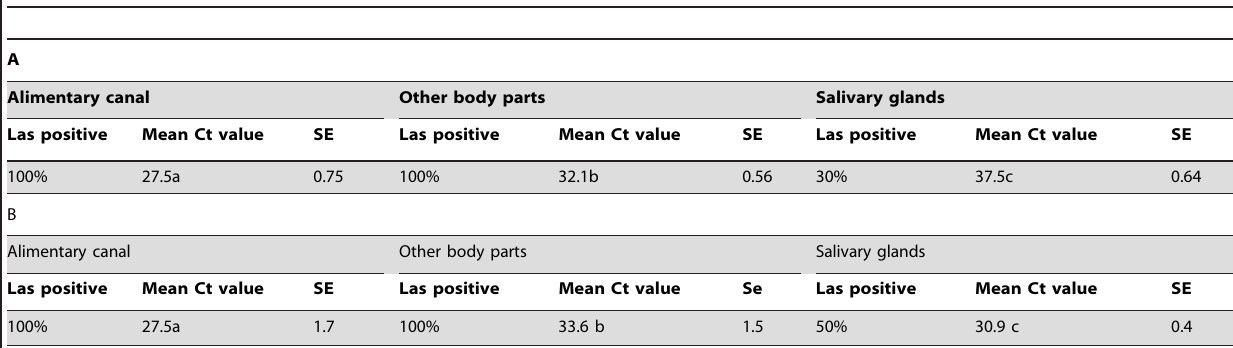
Table 2. Ct value of ‘Candidatus Liberibacter asiaticus’ (Las) in Ferrisia virgata organs based on qPCR for DNA from dissected adults and other body